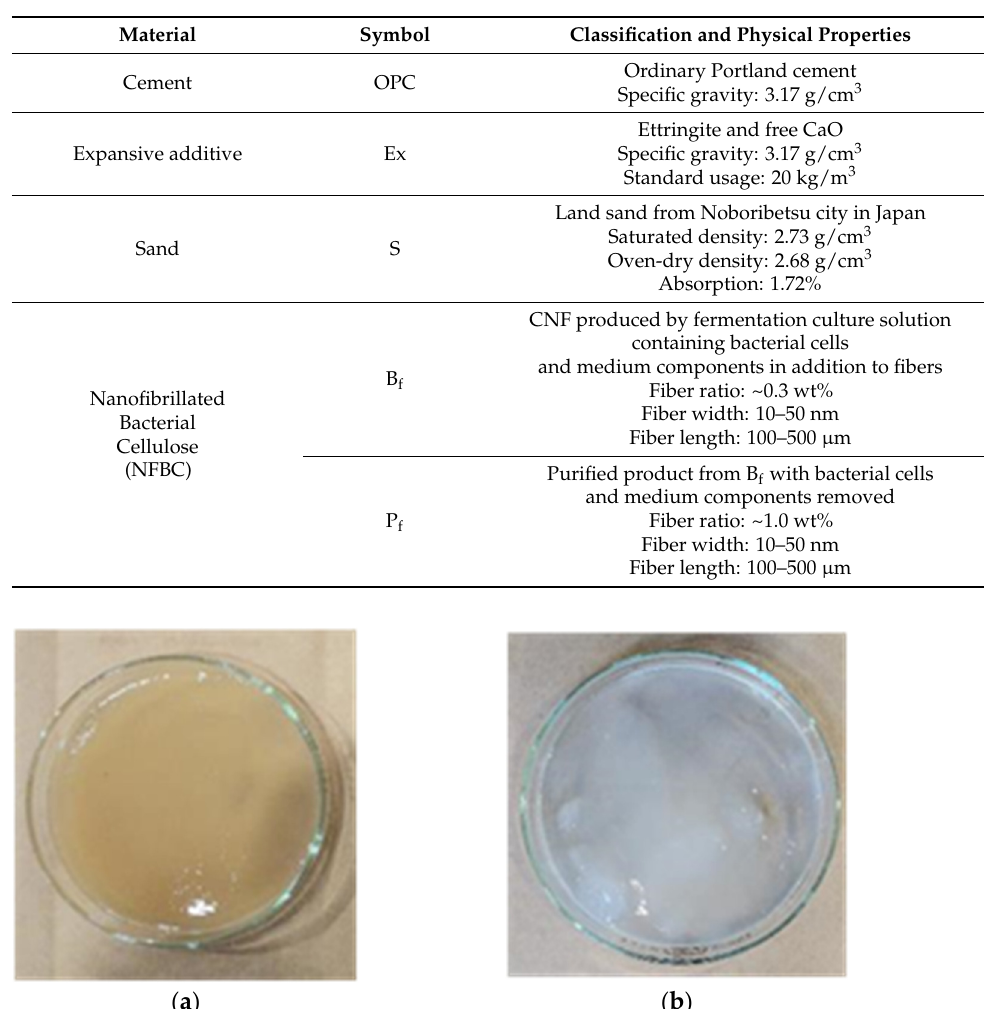
Figure 1. Photographs of the two types of NFBC: ( a ) the culture solution containing NFBC (B f ); ( b ) the purified solution is obtained by removing bacterial cells and medium components from B f (P f ).